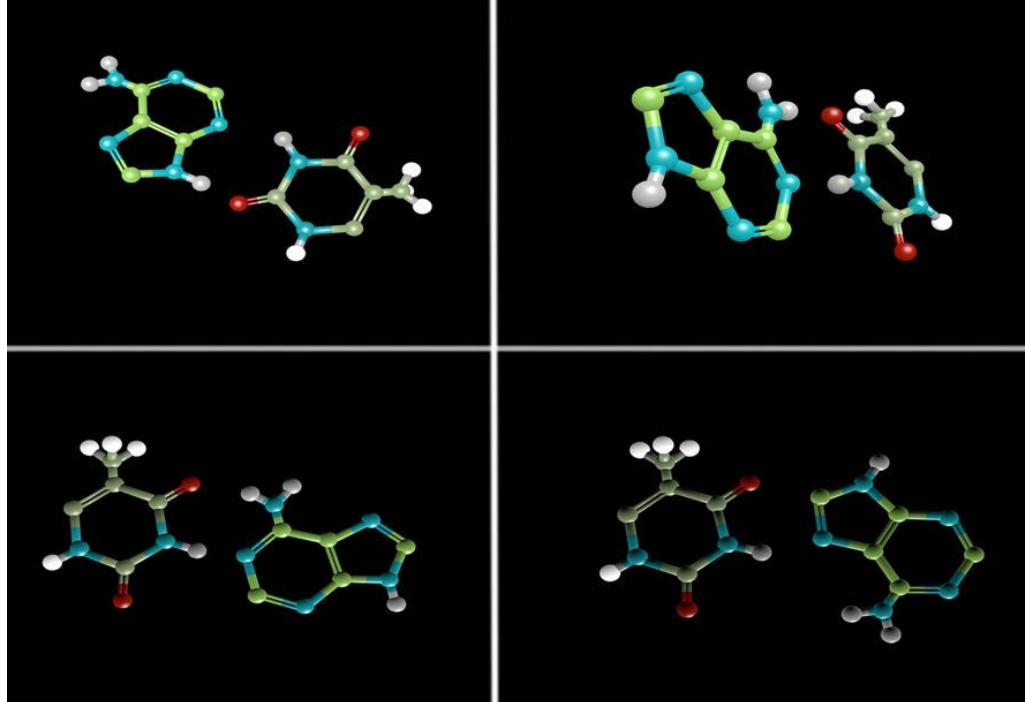
Figure 6. Examples of spatial recognition quizzes: Which two letters represent adenine and thymine?